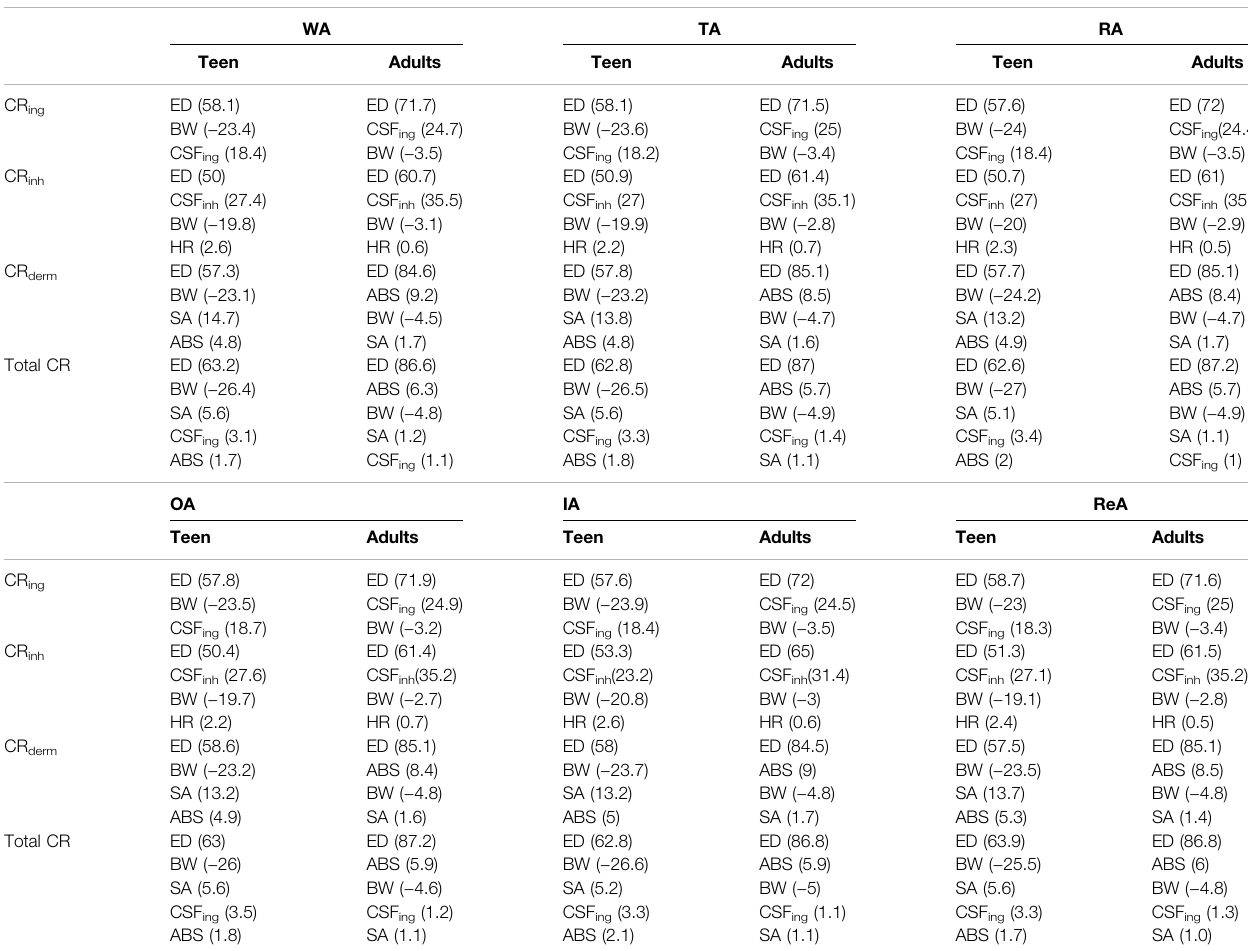
TABLE 4 | Monte Carlo sensitivity analysis results for CR assessment